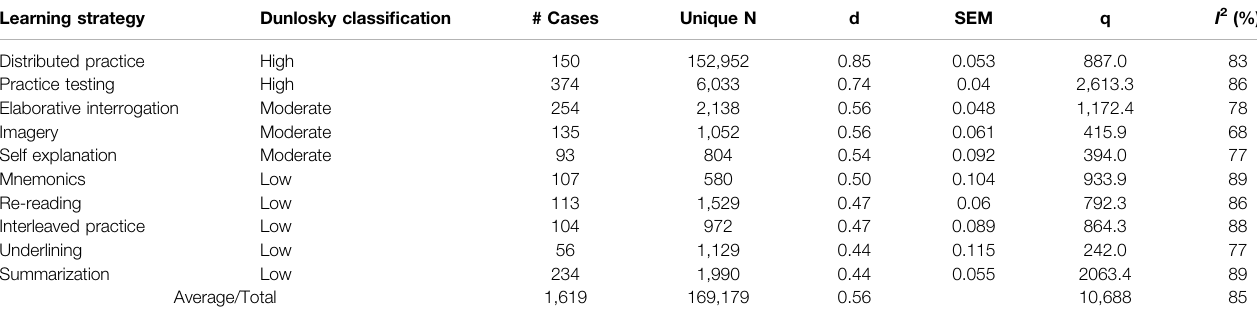
TABLE 1 | Summary of effects for each learning strategy. Learning strategy